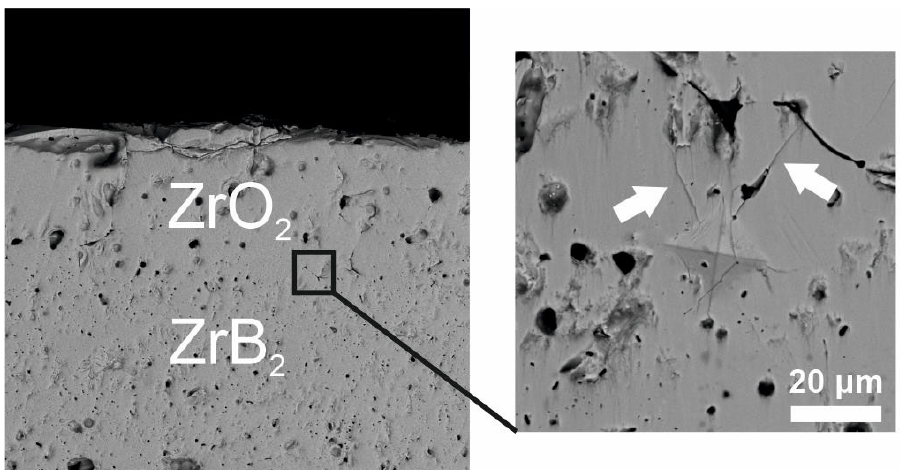
Figure 5. A Vickers indent on the cross ‐ sectional surface at the interface between the ZrO 2 coating and ZrB 2 –SiC substrate.